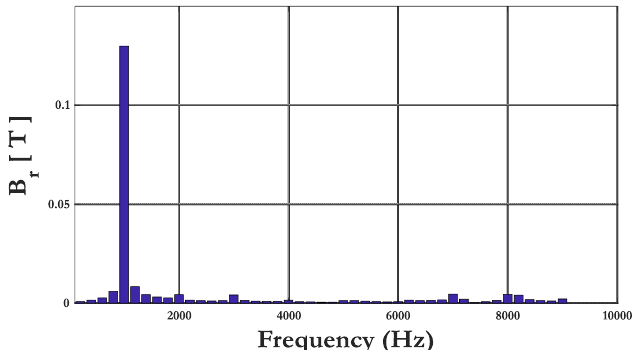
Figure 19. The frequency spectrum of the radial component of B in the middle of the North PM at 600 rpm.